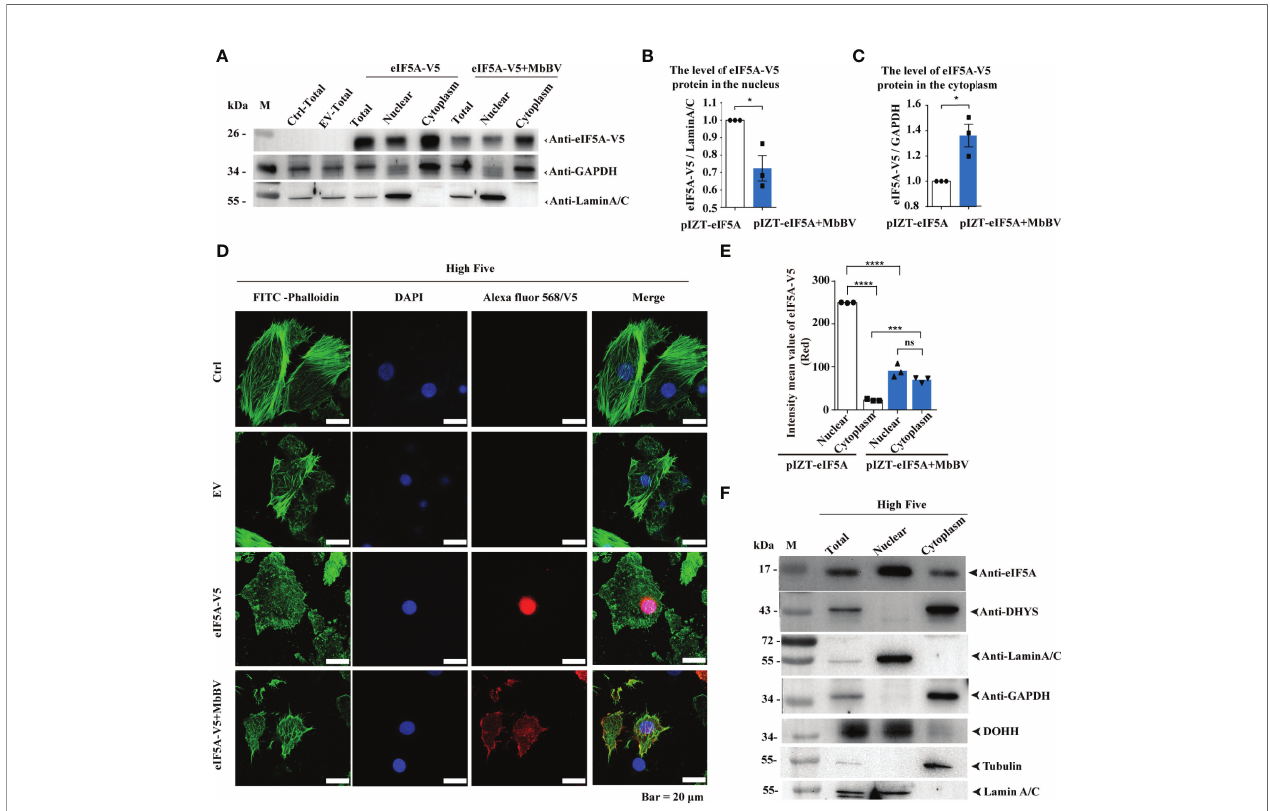
FIGURE 5 | Bracovirus activated hypusination via eIF5A nuclear-cytoplasmic transport. (A – C) Western blotting was used to detect the effect of MbBV on the localization of ectopically expressed eIF5A in High Five cells. The column summarizes the level of eIF5A, normalized to nucleoprotein and cytoplasmic protein respectively. * p < 0.05, error bars represent SEM. Unpaired Student ’ s t -test with Holm-Sidak method for multiple t test; n = 3. (D, E) Immuno fl uorescence was used to detect the effect of MbBV infection on the localization of V5-eIF5A in High Five cells. Scale bar, 20 m m. The column summarizes the mean fl uorescence intensity. *** p < 0.001, **** p < 0.0001, ns, no signi fi cant difference, error bars represent SEM. Unpaired Student ’ s t -test with Holm-Sidak method for multiple t test; n = 3. (F) Nuclear protein isolated to identify the localization of eIF5A, DHYS and DOHH. See also Figure S5